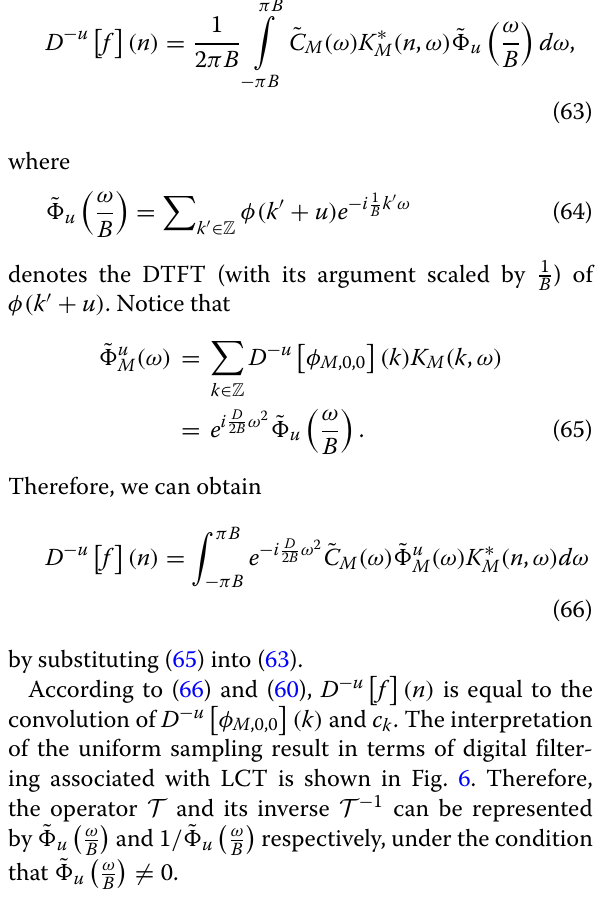
Table 1 Reconstruction performances comparison Metrics Definition Reconstructed